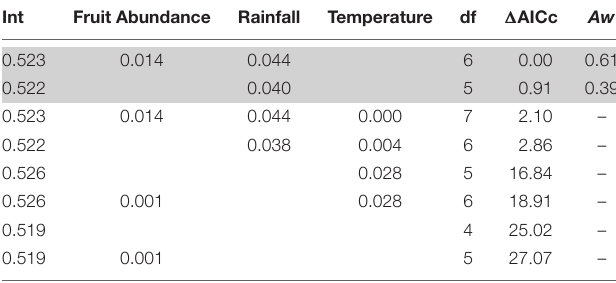
Values = the effect size of continuous predictors included in the model. See Table 1 for the full heading descriptions. ’Gray shading’ = models included in the top model set.